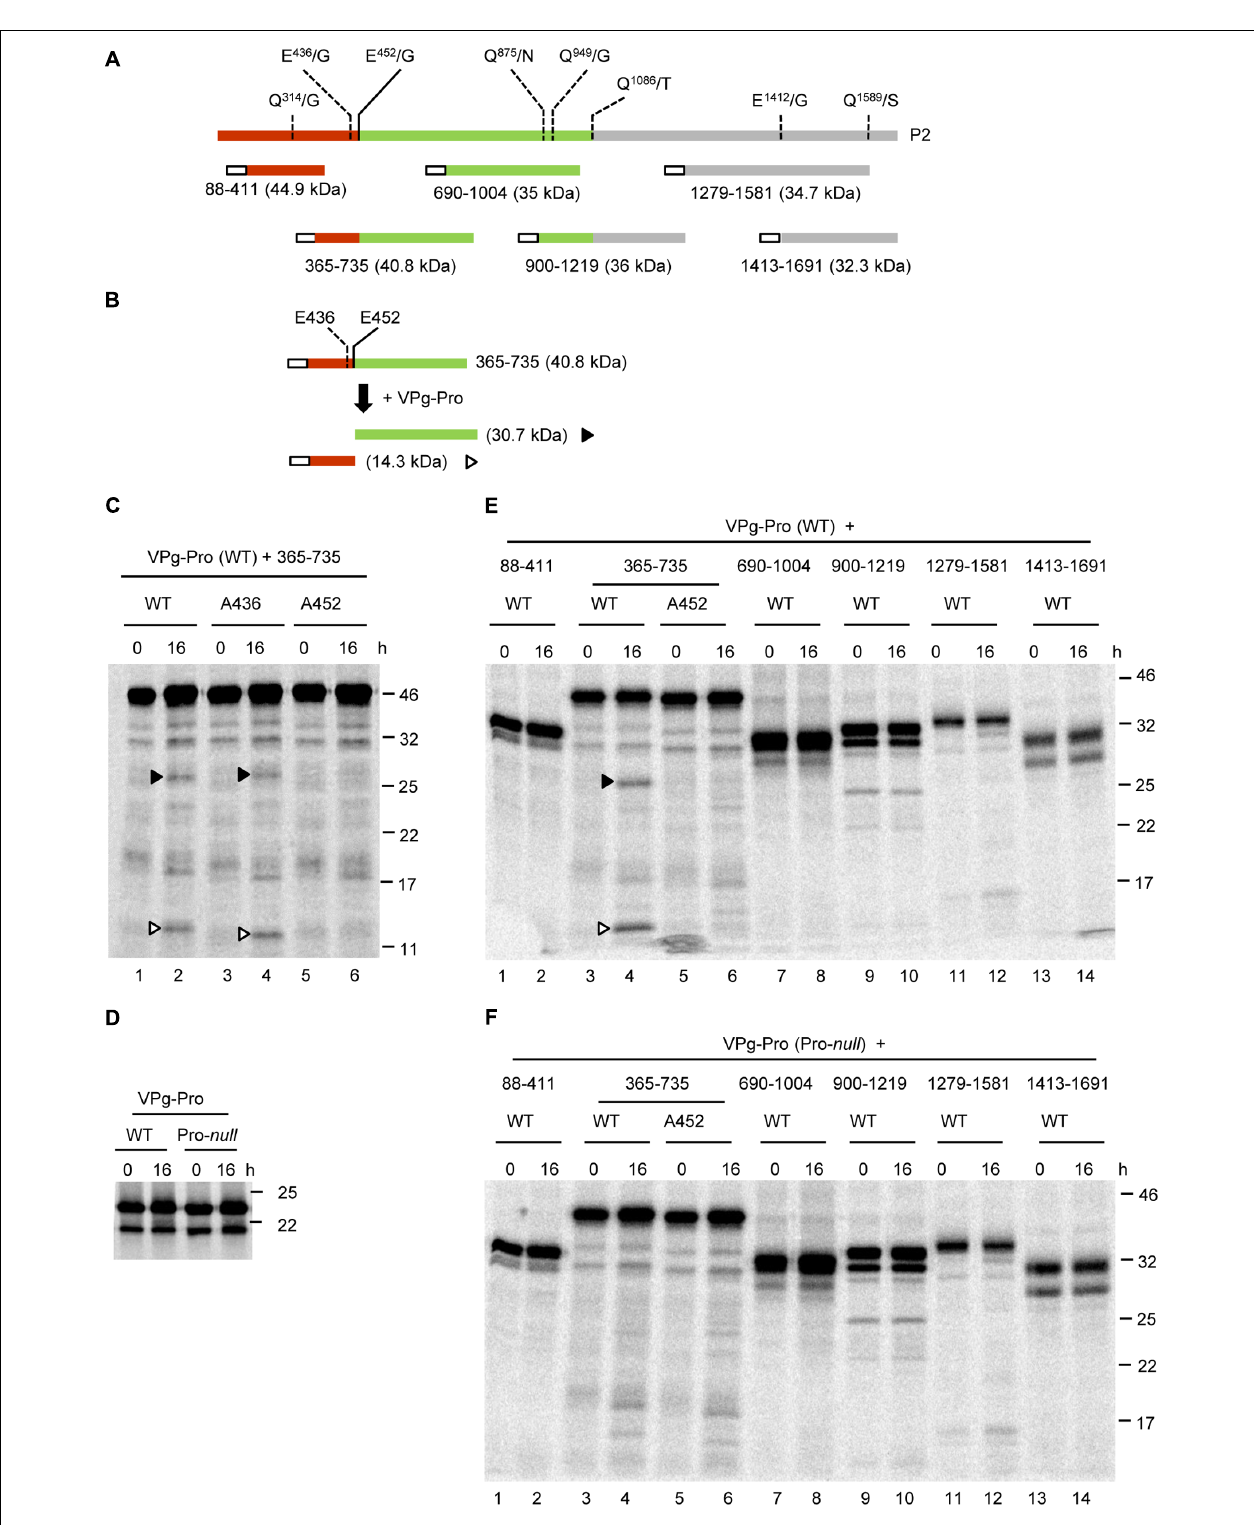
FIGURE 4 | In vitro trans -processing assays of partial P2 polyprotein precursor clones identify a single cleavage event between the MP and CP domains. (A) Schematic representation of the P2 polyprotein and the collection of overlapping partial polyprotein precursors. The predicted MP and CP domains are shown in brown and green, respectively. Putative cleavage sites are shown with the vertical lines and dashed lines represent cleavage sites that were not